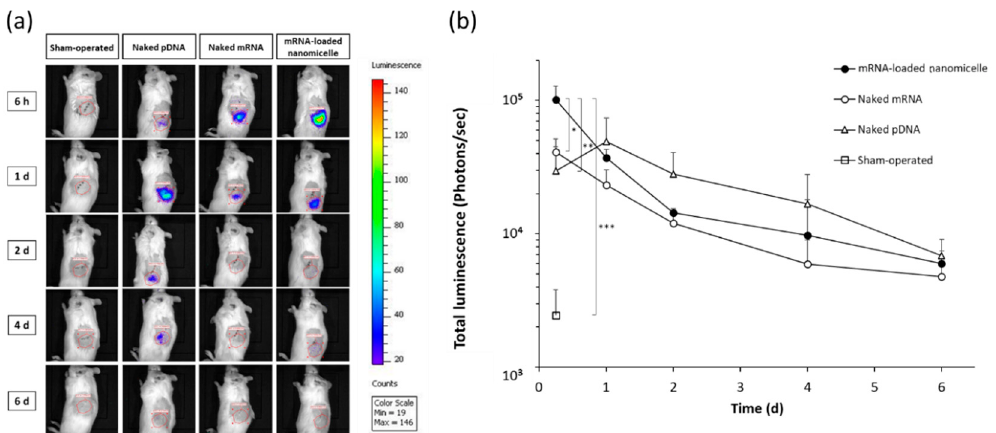
Figure 2. Time course of luciferase expression in the left kidney after renal pelvis injection of messenger RNA (mRNA) or plasmid DNA (pDNA) before in vivo imaging was performed. ( a ) Representative IVIS images of mice at 6 h, 1, 2, 4, and 6 d after renal pelvis injection of naked pDNA, naked mRNA, or mRNA-loaded polyplex nanomicelles. ( b ) Quantification of luciferase expression was performed with the total luminescence (photons/sec) in the left kidney was determined by same size of ROI. Data are represented as mean + SD (n = 3 – 4). * p < 0.05 , ** p < 0.01 , *** p < 0.001 (Tukey’s test).